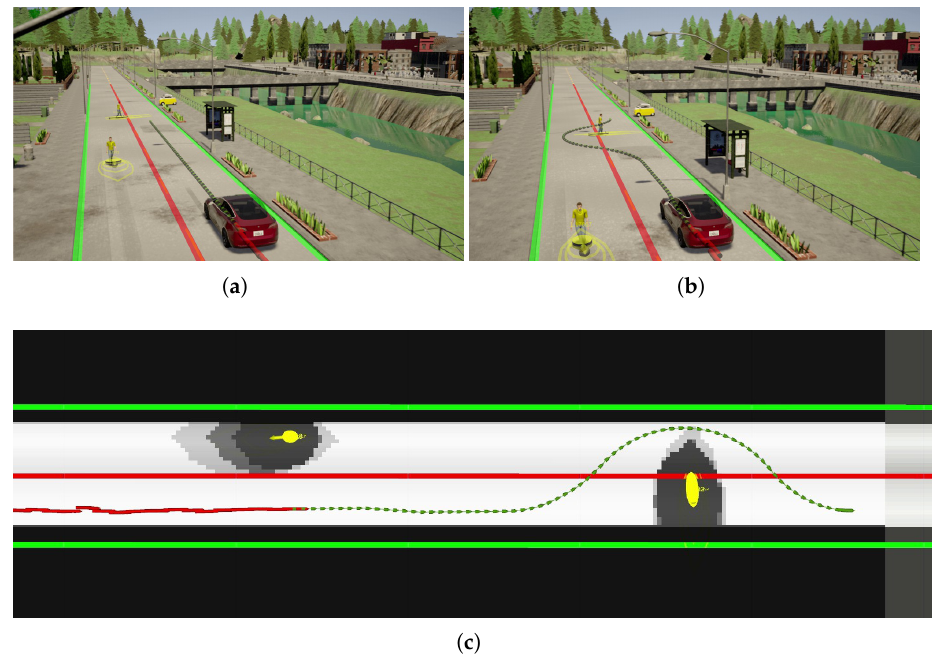
Figure 18. The pedestrian tracking in the CAV relying only on CPMs from the IRSU in the CARLA simulator. ( a ) and ( b ) show the two walking pedestrians and the planned path in the CAV at different time instances. In ( c ), the grid-based cost map maintained by the path planner in the CAV is presented with white as free space and black as occupied areas, the tracked pedestrians are visualised with 95% confidence ellipses and arrows indicating their moving direction, and the odometry trajectory is shown as a red line, and the planned path is presented as a dotted green line.